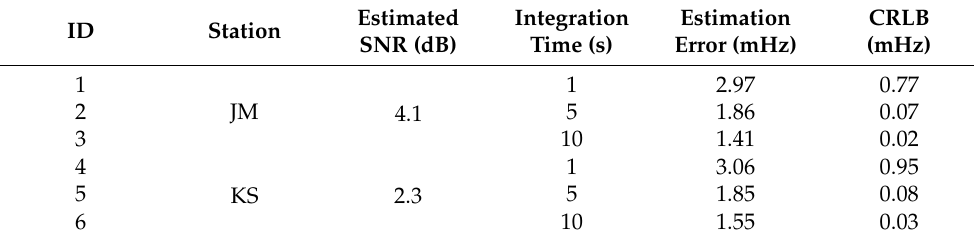
Figure 8. The residual frequency estimation of Tianwen-1 raw data at JM station. Table 2. The frequency estimation results of Tianwen-1 (observed on 26 February